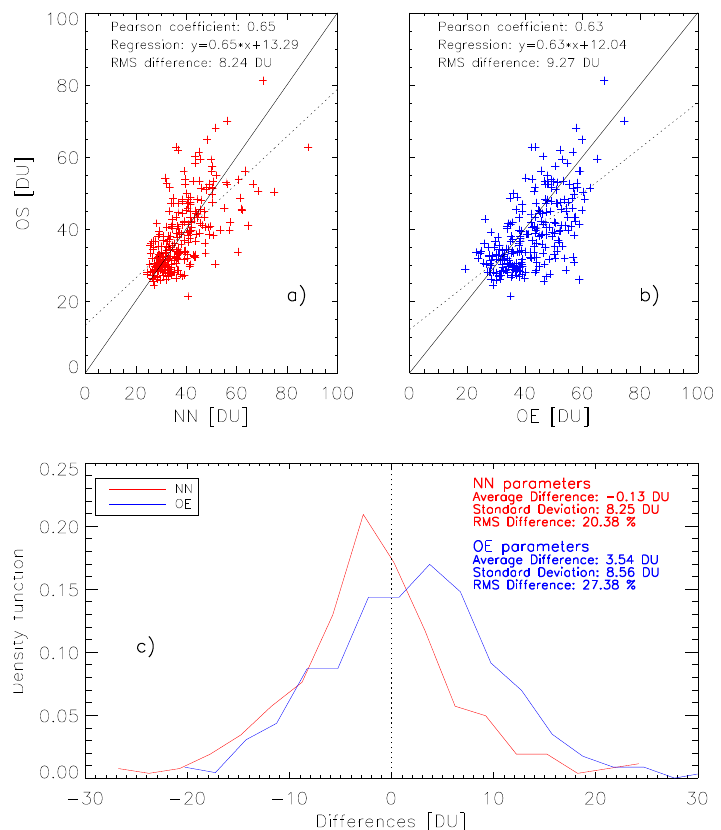
Fig. 6. Scatter plot of OMI-TOC NN retrievals (in red) and OE (in blue) versus corresponding OS true data (a,b); histogram of the absolute deviations of OMI-TOC NN retrievals (in red) and OE (in blue) with respect to the OSs reference values, for the European points of the test data set. Statistical parameters are also reported (c).